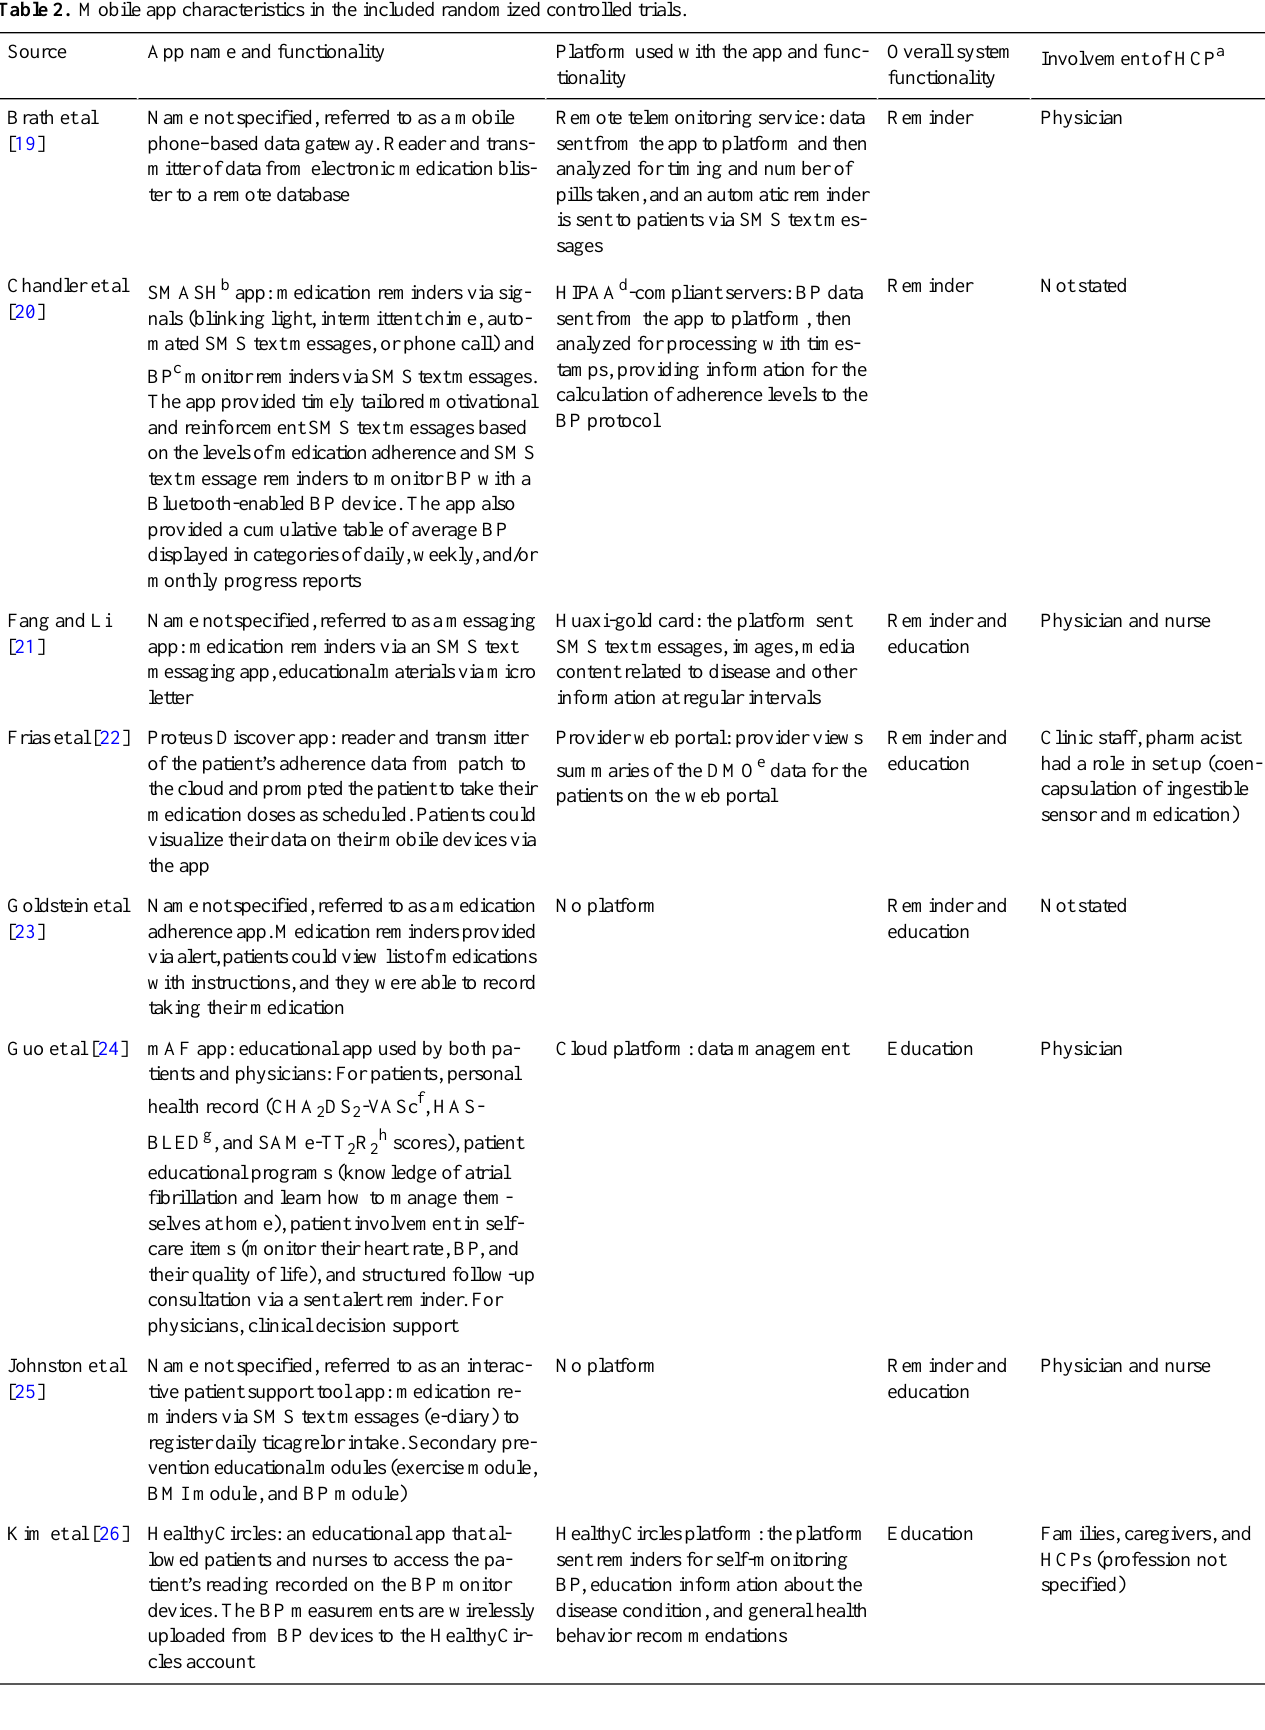
Table 2. Mobile app characteristics in the included randomized controlled